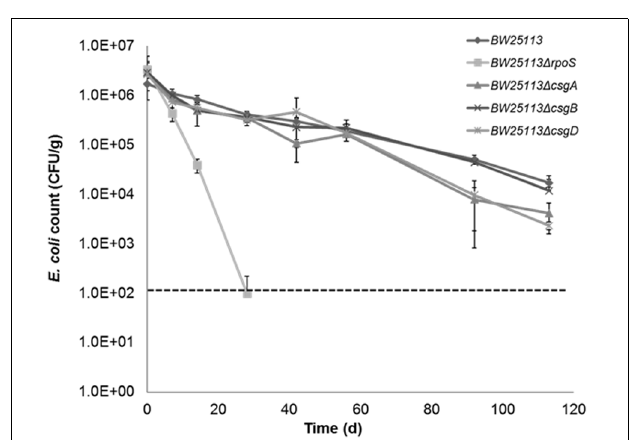
FIGURE 7 | Curli are not required for Escherichia coli to survive in soil. Soil survival was performed by inoculating wildtype and mutants into live soil and incubated at 15 ◦ C. Dashed line represents detection limit of soil survival